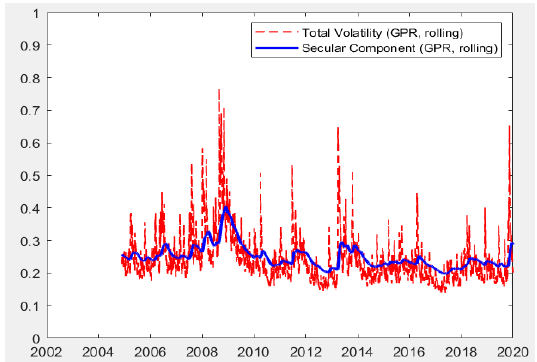
Figure 2. Total Variance and Long-Run Component with GPR.